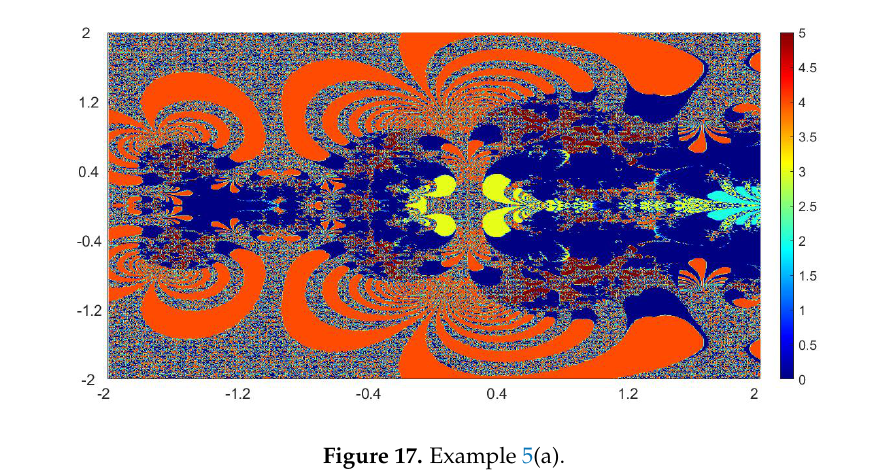
Figure 17. Example 5(a).